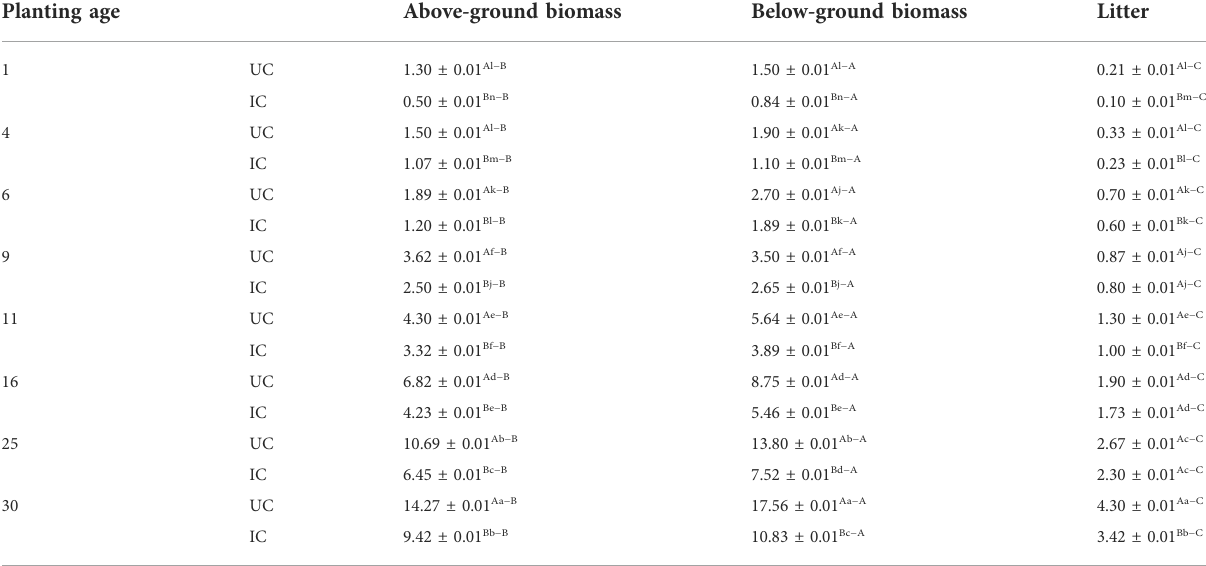
TABLE 3 Plant C pool (ton ha − 1 ) in the eight Calligonum planting